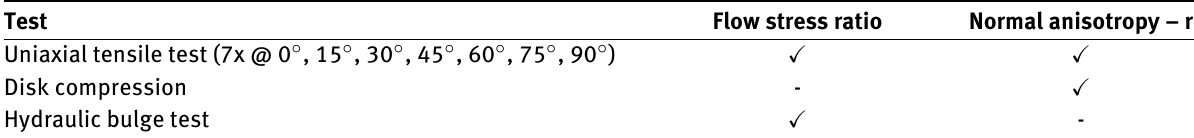
Table 5: Summary of experimental data used in calibration of the Yld2000-2d model Test Flow stress ratio Normal anisotropy – r